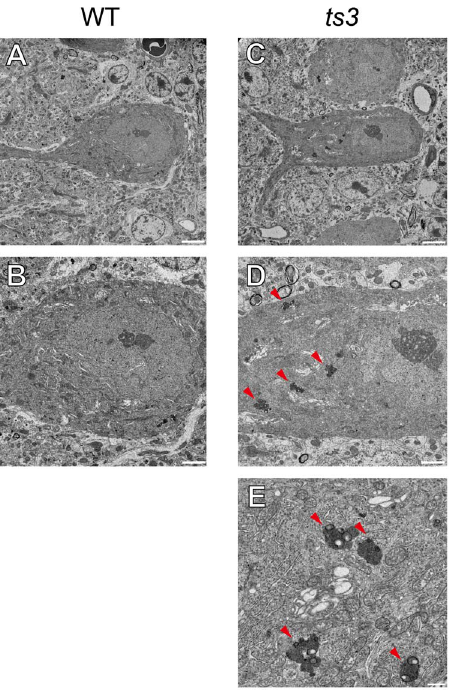
Figure 6. Abnormal morphology of dendrites and spines of the Purkinje cells in ts3 mutants. A) Representative ultra-high voltage electron microscopy (UHVEM) images of Purkinje cell dendrites in ts3 mutant and WT mice (2000x). The arrow in the lower panel indicates isthmic portions of dendrites observed in ts3 mutants. Note the significant difference in morphology between ts3 and WT cerebella. Whereas the bulbous shape of dendritic spines is observed in WT controls, dendritic spines in ts3 mutants are smaller and irregularly- shaped, as indicated by arrowheads. Scale bar indicates 5 m m. B) Dendritic spine density (number of spine/ m m 2 ) was comparable in ts3 and WT controls. C) Morphology of the dendritic spines is significantly different in ts3 mutants when compared to that of WT controls. Whereas stubby or mushroom-shaped spines, which are characteristic of normal and mature PCs, are commonly observed in WT cerebella, thin (filopodia-like or headed) spines, representing a deficit in spine maturation, are predominant in ts3 mutants. Double-headed spines, including branched spines, were rarely observed in either genotype. ‘‘Unknown’’ indicates spines that could not be categorized from HVEM images by gross observation due to high density of dendritic spines in PCs. The x 2 test indicated that the difference in dendritic morphology between two genotypes is statistically significant ( p , 0.01).